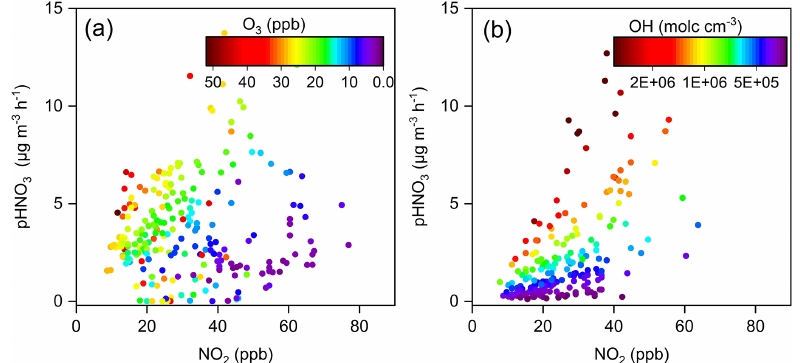
Figure 10. Production rates of HNO 3 from the (a) heterogeneous and (b) gas-phase processes as a function of NO 2 concentration at the Pudong site during the nighttime and daytime, respectively. The circles are colored according to the O 3 concentration in (a) and OH radical concentration in (b)